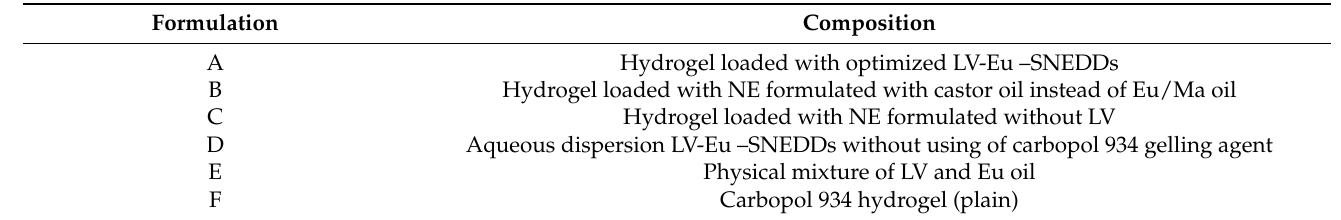
Table 7. Details of samples prepared for the characterization and evaluation of the LV-Eu-